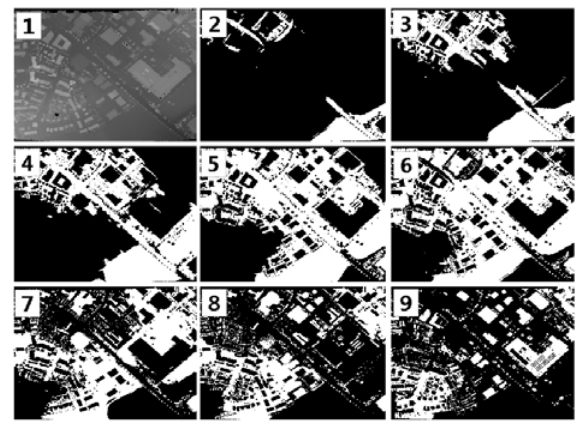
Figure 1. the first is elevation map; 2-9 are layers with different height.